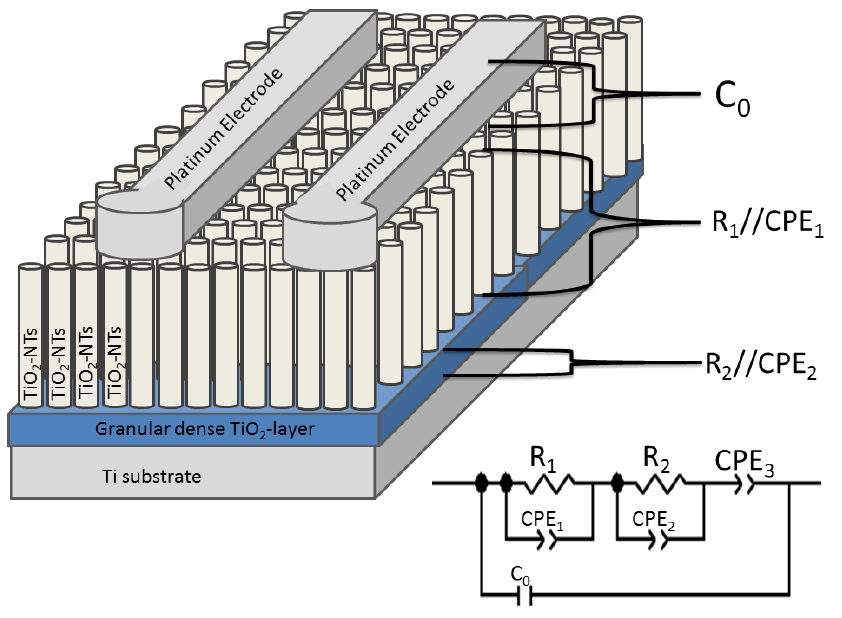
: capacitive, R and R : 0 1 2